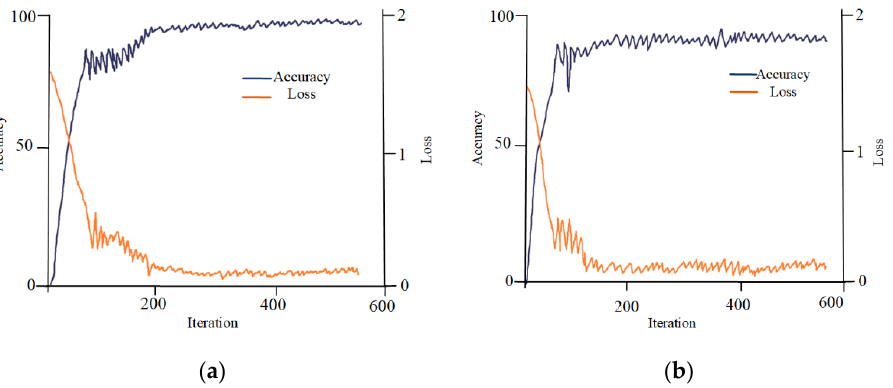
Figure 9. Training process of Inception V3-LSTM framework. ( a ) Training process using 100% datasets; ( b ) Training process using 70% datasets.